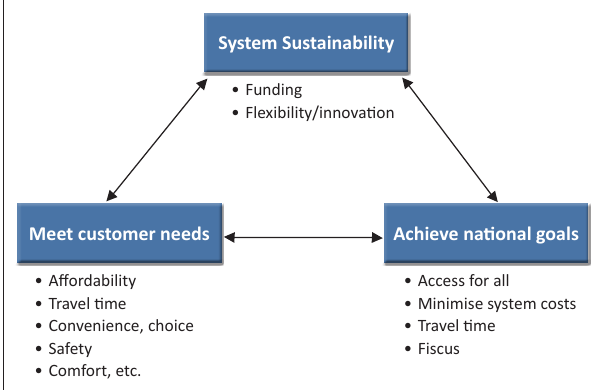
FIGURE 1: Public transport